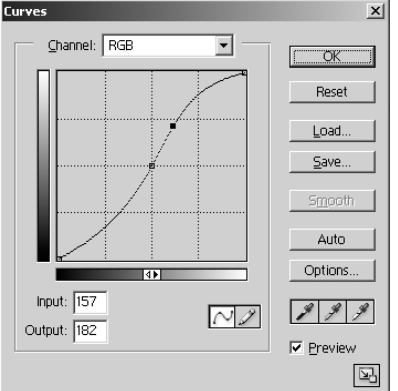
Fig 7. Properties of function